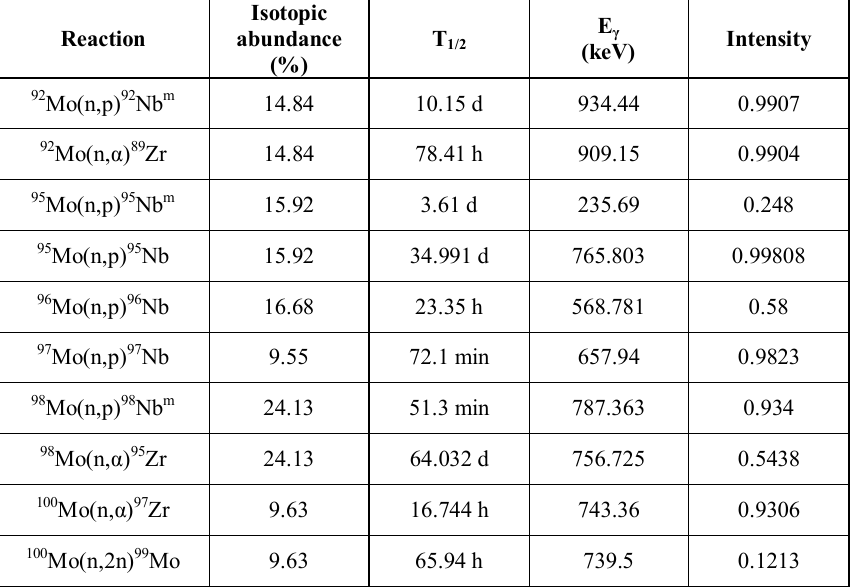
Table 1. Decay data for the studied reactions